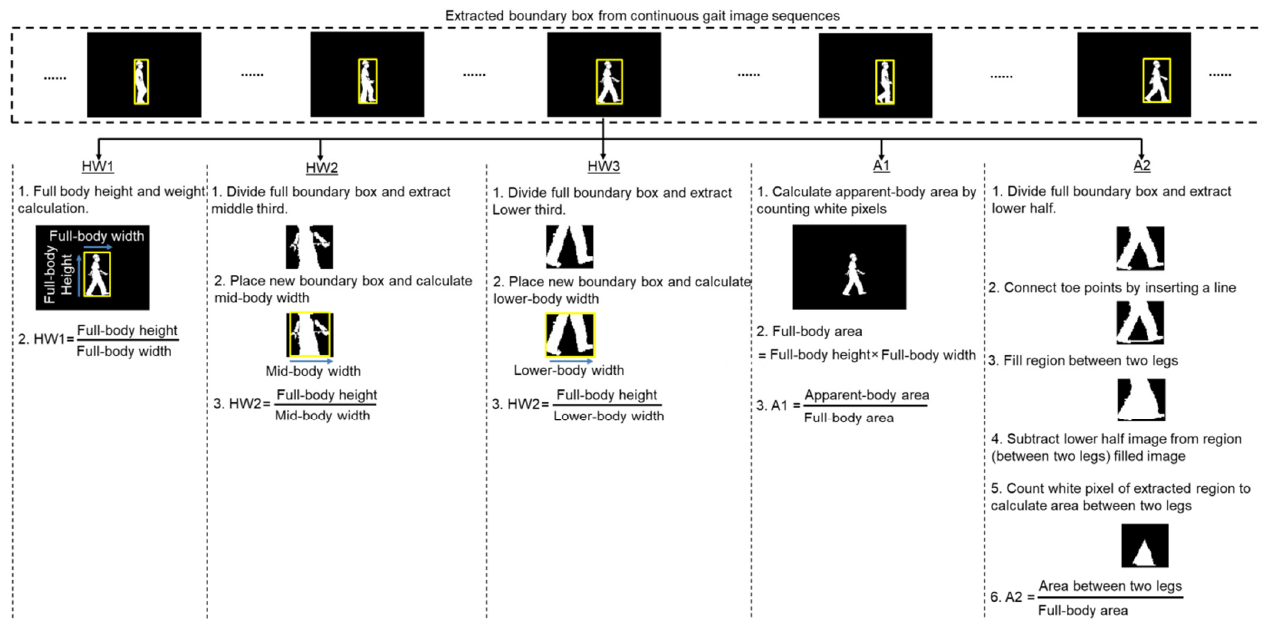
Figure 1. Graphical representation showing the extraction of the five ratio-based body measurements from an image sequence. Here, HW1—ratio of the full-body height to the full-body width; HW2—ratio of the full-body height to the mid-body width; HW3—ratio of the full-body height to the lower-body width; A1—ratio of the apparent to the full-body area; A2—ratio between area between legs and full-body area.